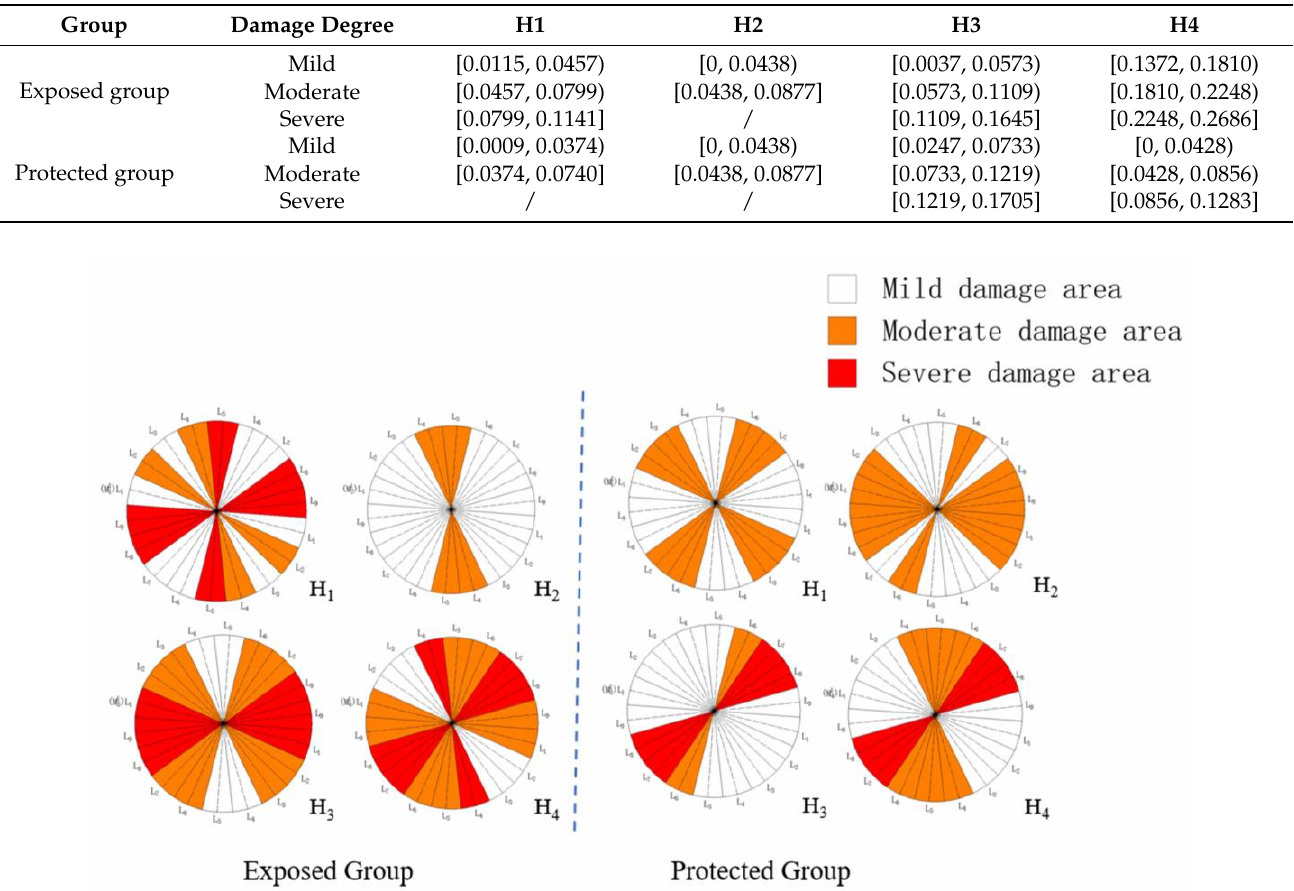
Table 9. The d i , j value interval of the damage degree on each surface.